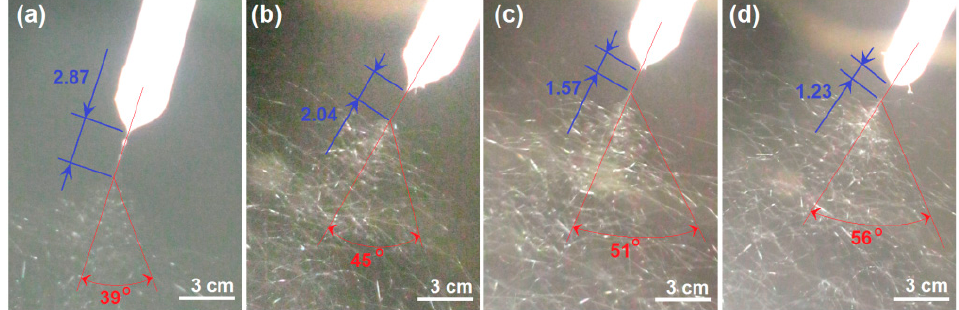
Figure 4. The typical changes of straight fluid jets and instable regions with the elevation of applied voltages (kV): ( a ) 13; ( b ) 14; ( c ) 15; ( d ) 16.